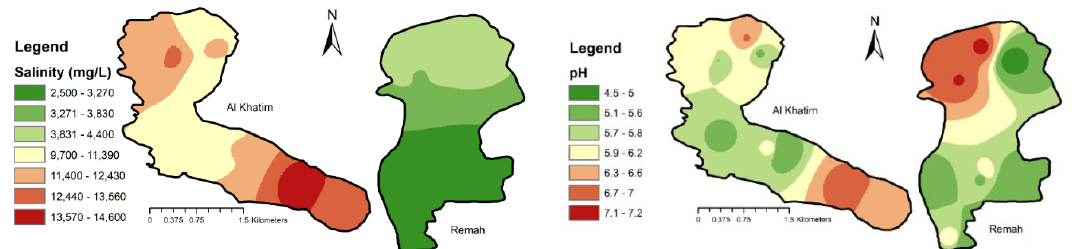
Figure 6. Spatial distribution of electrical conductivity (EC), salinity, and pH.